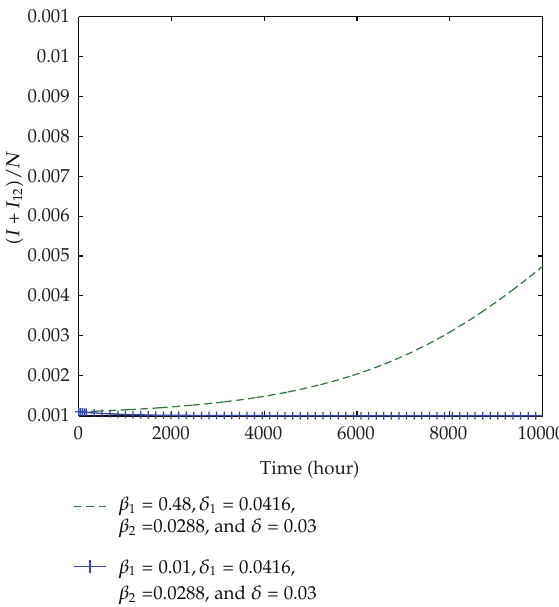
Figure 2: Fraction of computers infected with noncooperative worm: (cid:3) iii (cid:4) green: the cooperative worm > 1 and (cid:3) iv (cid:4) blue: the cooperative worm dies out and R 2 exists and R 12 0